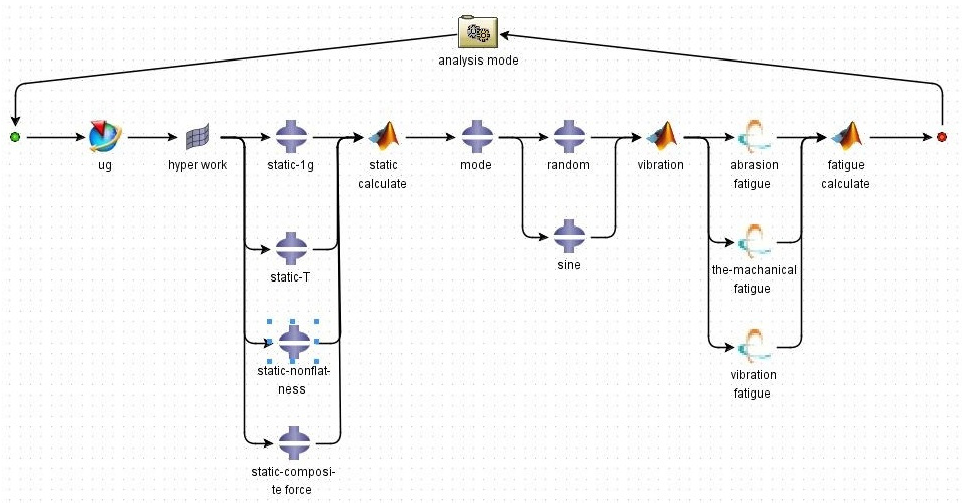
Figure 7. Design route in ISIGHT software.